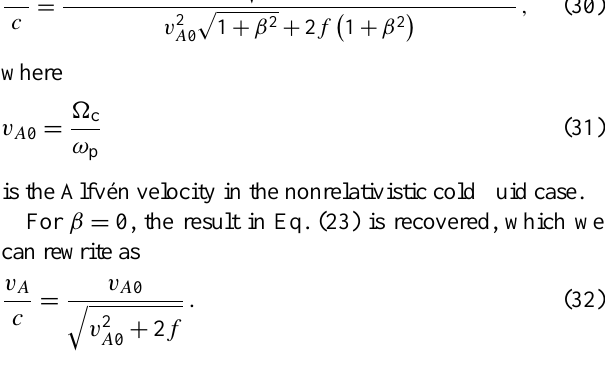
Fig. 3. Isocontours of real solutions of Eq. (29) as a function of normalized drift β and normalized frequency x , for positrons. Each panel corresponds to a different branch, γ (s) p , for the roots of Eq. (29). A few contour levels are shown. Physically acceptable solutions are in the regions where γ(x,β) is real and greater than 1. Fixed values y = 0 . 3, α = 0 . 1, and f = 1 were taken. (a) s = 1, (b) s = 2, and (c) s =